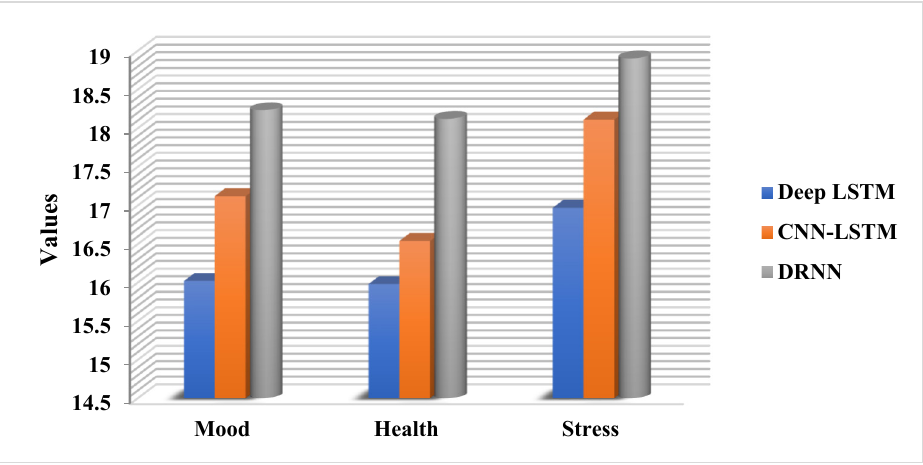
Table 4. Mood, health, and stress prediction outcomes of existing and proposed classification tech- niques.